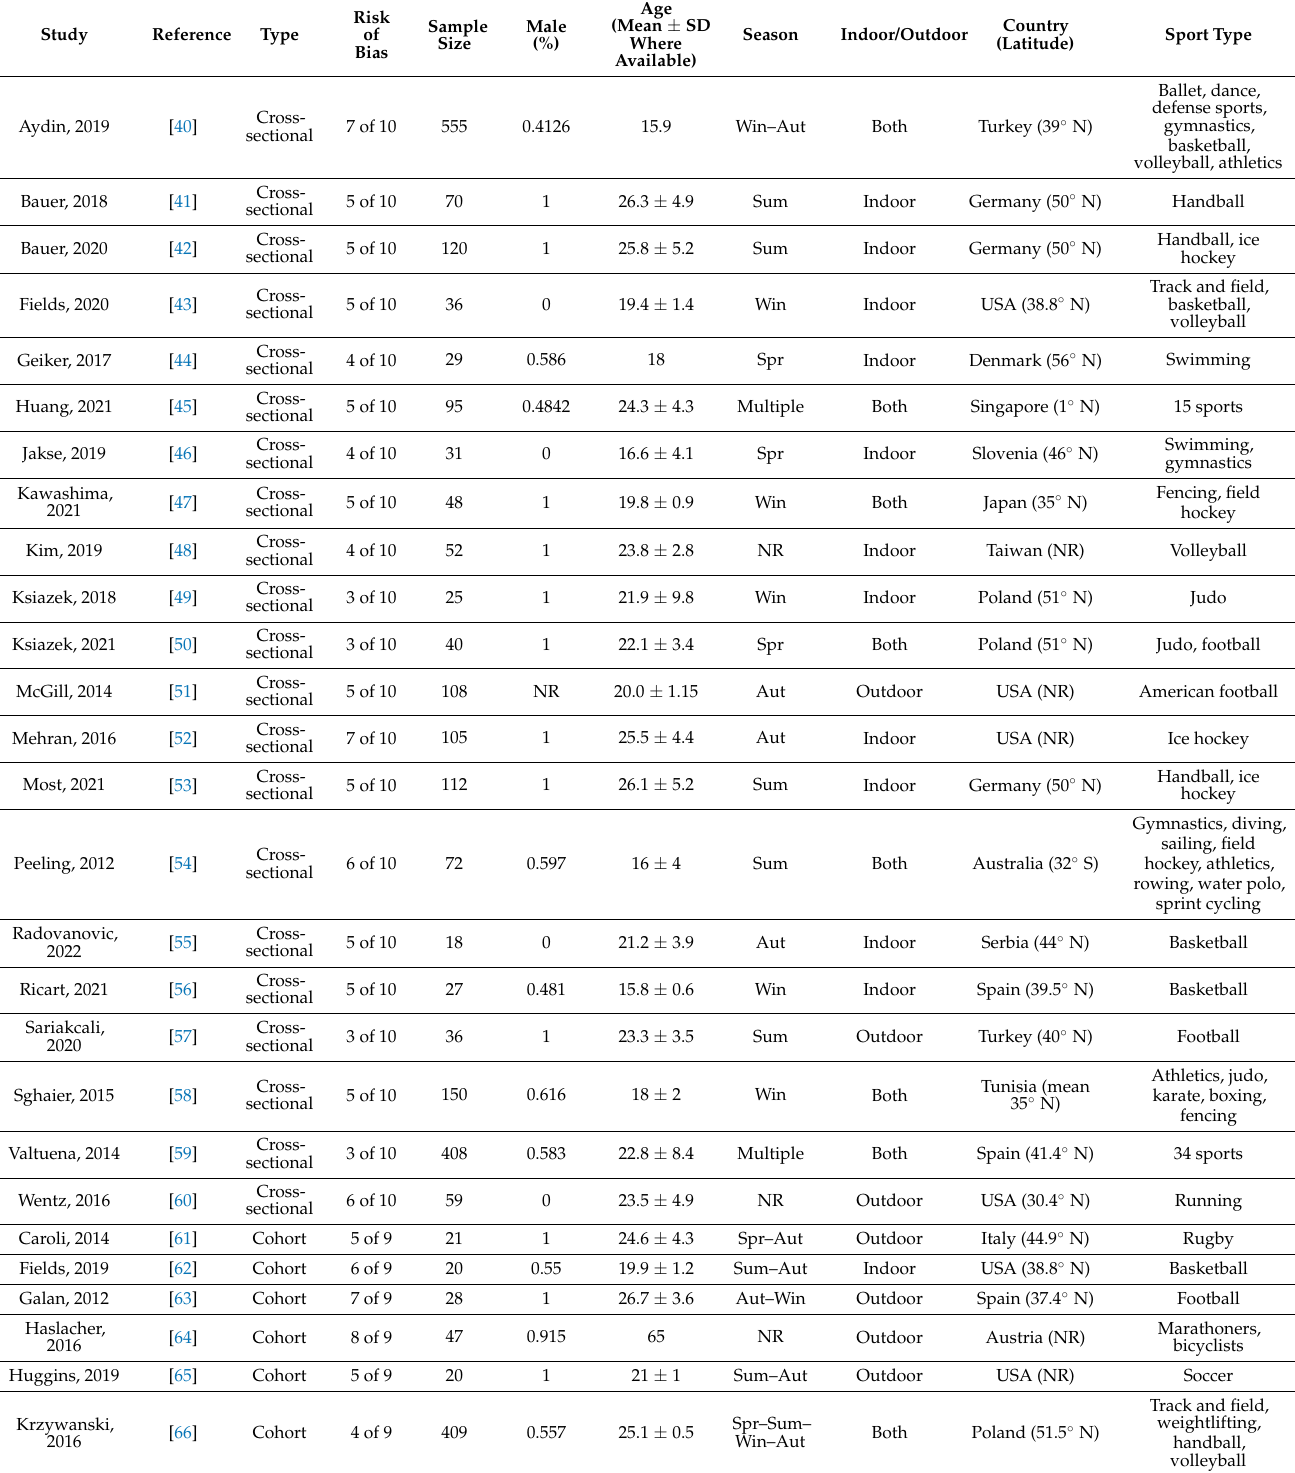
Table 1. Characteristics of included studies. NR = not reported. Multiple = vitamin D sampled at multiple time points but not reported separately. Win = winter. Aut = autumn. Sum = summer. Spr =